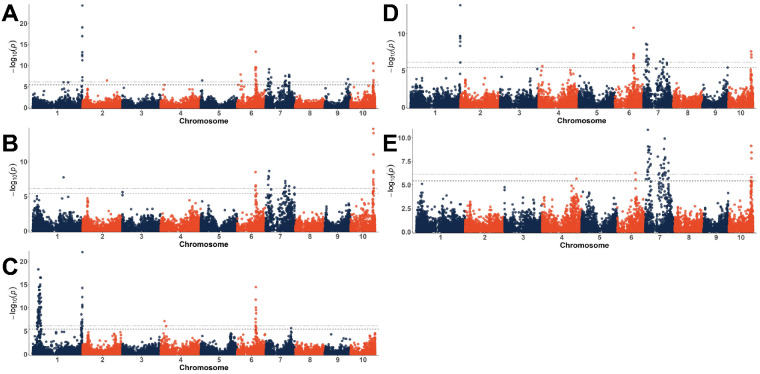
Manhattan plots for total anthocyanin content in μg/ml (A, B; sqrt transformed), the molar proportion of anthocyanins (C) and maximum absorbance (D, E; log transformed). A and D contain data from the full population while B and E contain only the lines with proportions of acylated anthocyanins between 0.35 and 0.7. Dotted lines indicate the experiment-wide significance thresholds using the Bonferroni correction. (αE=0.05 and αE=0.01).